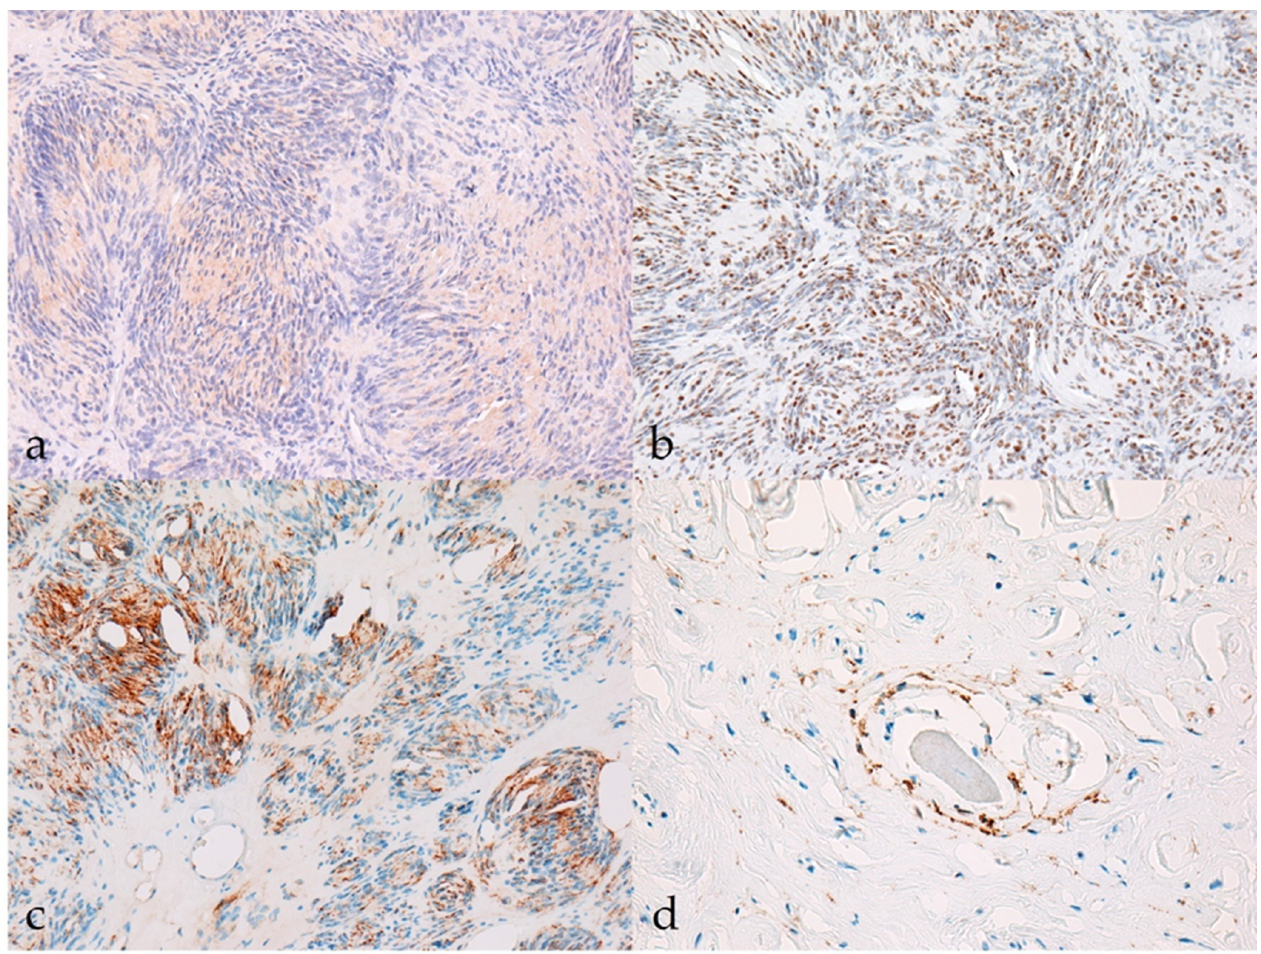
Figure 2. Immunohistochemical characteristics of benign nerve sheath tumors (BNSTs). ( a ) The cytoplasm of neoplastic cells in classical schwannoma shows mild immunoreactivity (+) for CNPase (case no. 10). CNPase, 200×. ( b ) Classical schwannoma showing diffuse strong nuclear immunore- activity (+++) for Sox10 (case no. 10). Sox10 , 200×. ( c ) Multifocally (less than 50% of tumor), the cyto- plasm of neoplastic cells in classic schwannoma moderately to strongly expresses GFAP (++) (case no. 10). GFAP, 200×. ( d ) Claudin-1 membranous immunoreactivity (++) of neoplastic perineurial cells in the perineurioma regions of hybrid NST (case no. 23). Claudin-1, 400×.